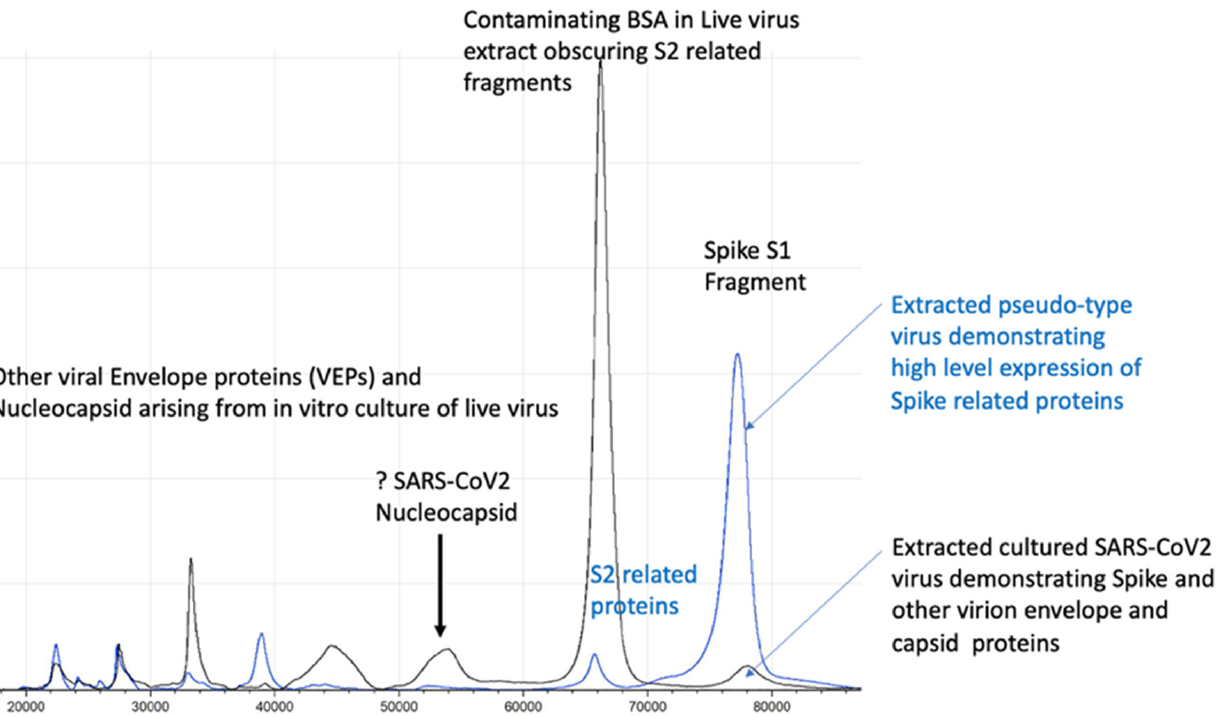
Figure 5. Illustration of full profile of virion proteins detected by MALDI–ToF not seen in pseudo- type virus.